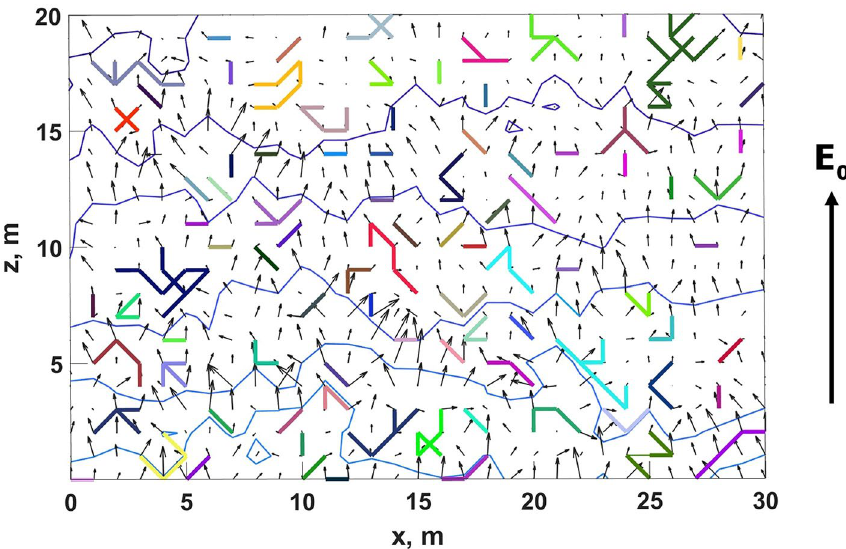
Figure 3. Illustration of the state of the model system for more demonstrative 2-D case. Individual equipotential clusters are shown in different colors. Blue lines and black arrows denote isolines of potential and electric field direction, respectively. At a given moment of time an ambient electric field E 0 is highly distorted by the preceding random dynamics of perfectly conducting